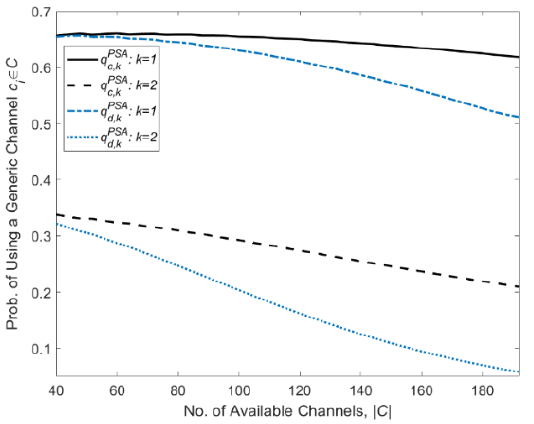
Figure 5. The 𝑞 𝑐,𝑘PSA and 𝑞 𝑑,𝑘PSA in the underlay in-band D2D mode vs. the total number of available Figure 5. The q PSA and q PSA in the underlay in-band D2D mode vs. the total number of available c , k d , k channels |Ϲ| in each macrocell. channels | C | in each